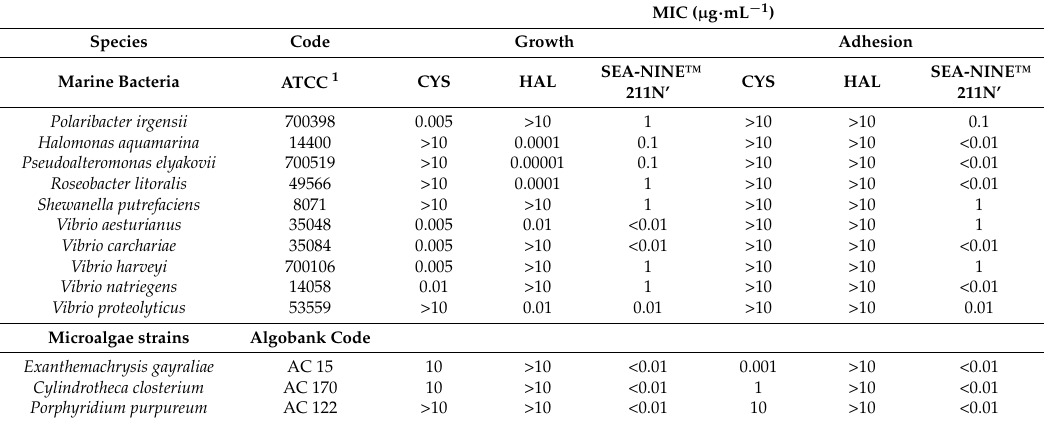
Table 2. Antibacterial and anti-microalgal properties of CYS and HAL aqueous